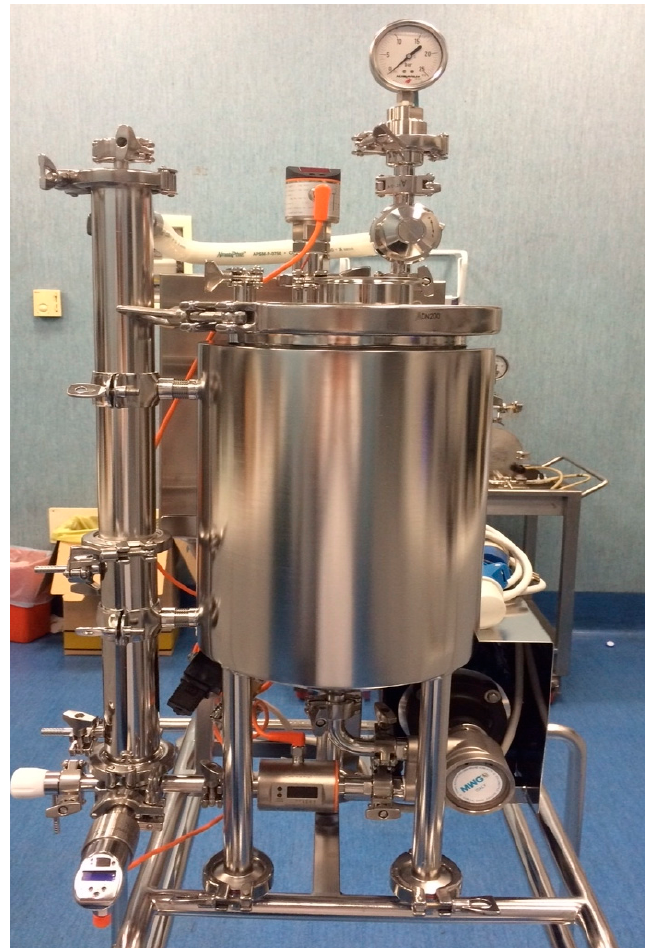
Figure 1. UF-NF (ultrafiltration-nano-filtration) system.